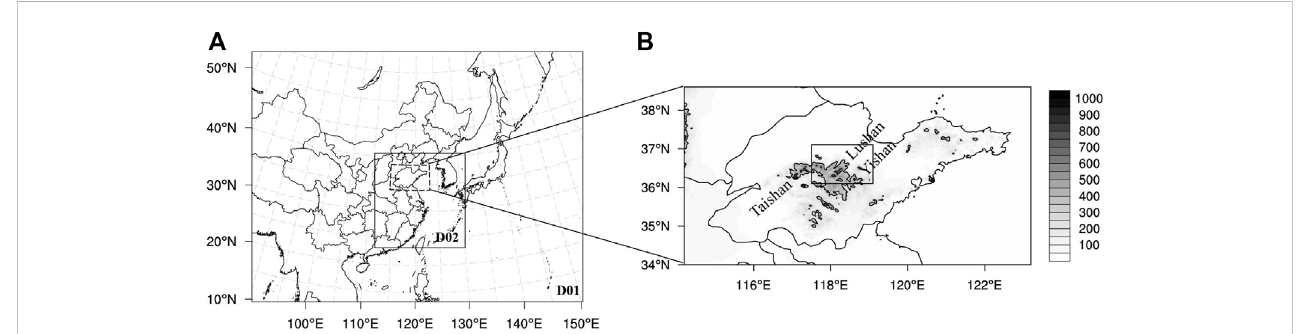
FIGURE 1 (A) Domains for numerical simulations, where outer domain D01 and inner domain D02 have 12- and 2.4-km horizontal grid spacings, respectively; (B) Zoomed terrain height (shaded; unit: m) of the black dashed box in (A) near Shandong Province with the main mountains. Black contours in (B) show the terrain heights of 300 m and 600 m. The black solid box in (B) indicates the heavy rainfall area as in Figure